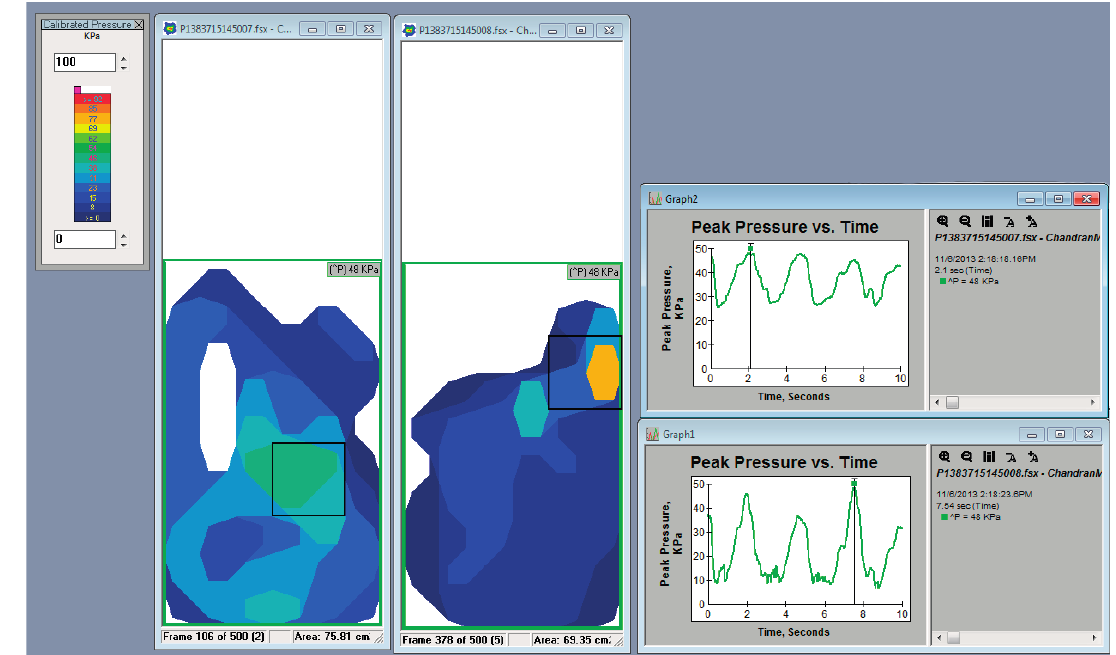
Figure 6. Data and graphs show pressure distributing and the pick points of pressure.